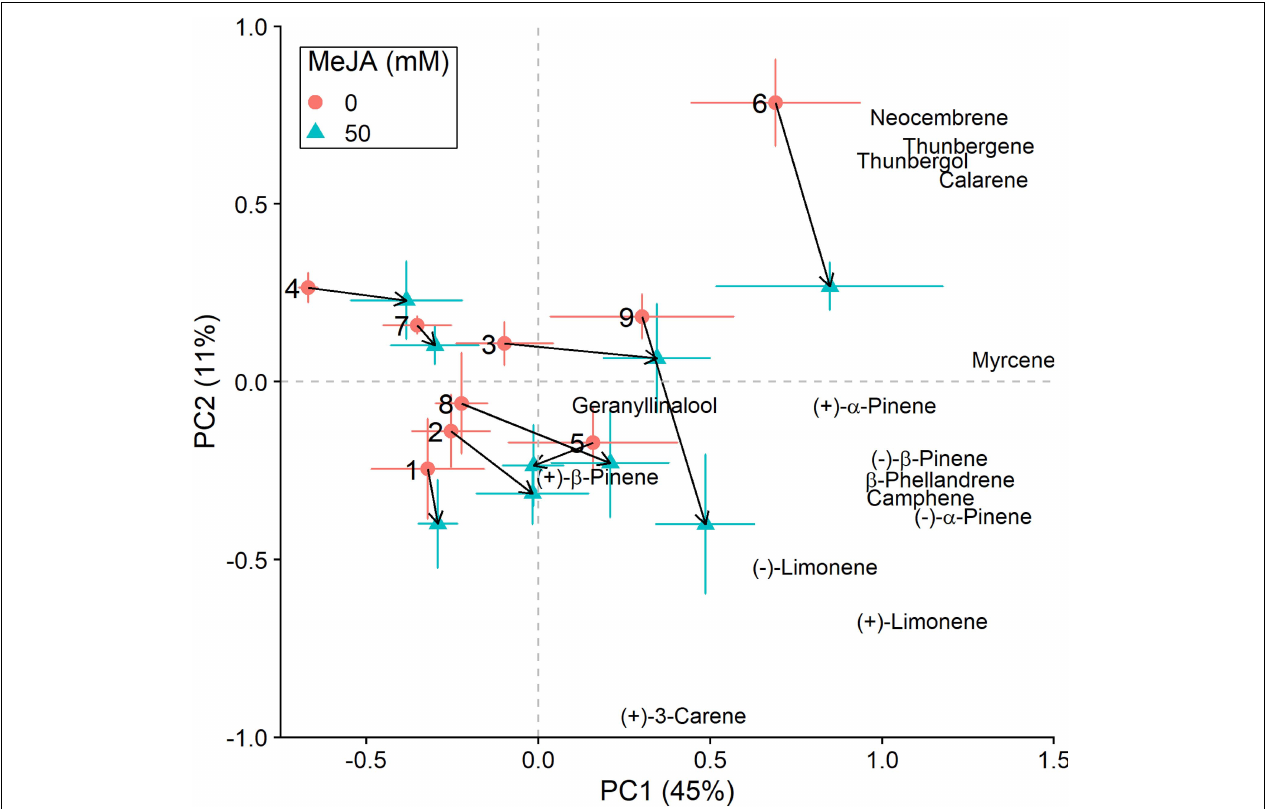
FIGURE 3 | Principal component analysis (PCA) biplots (for non-fungus inoculated plants) of total absolute terpene amounts. Variation along the two main axes of variation (PC 1, PC 2; % variation explained by each axis) is shown for methyl jasmonate-treated (50 mM MeJA, blue filled triangles) and non-treated (0 mM MeJA, orange filled circles) clones of Norway spruce ( P. abies ). Mean PCA score values ± standard error for each clone (1–9) are shown, as well as the direction and distance of change (black arrows) in terpene chemistry between the two MeJA treatments. The position of terpenes indicates PCA loadings (vectors), which illustrate each compound’s correlation with the two axes of variation (see Table 3 for loading